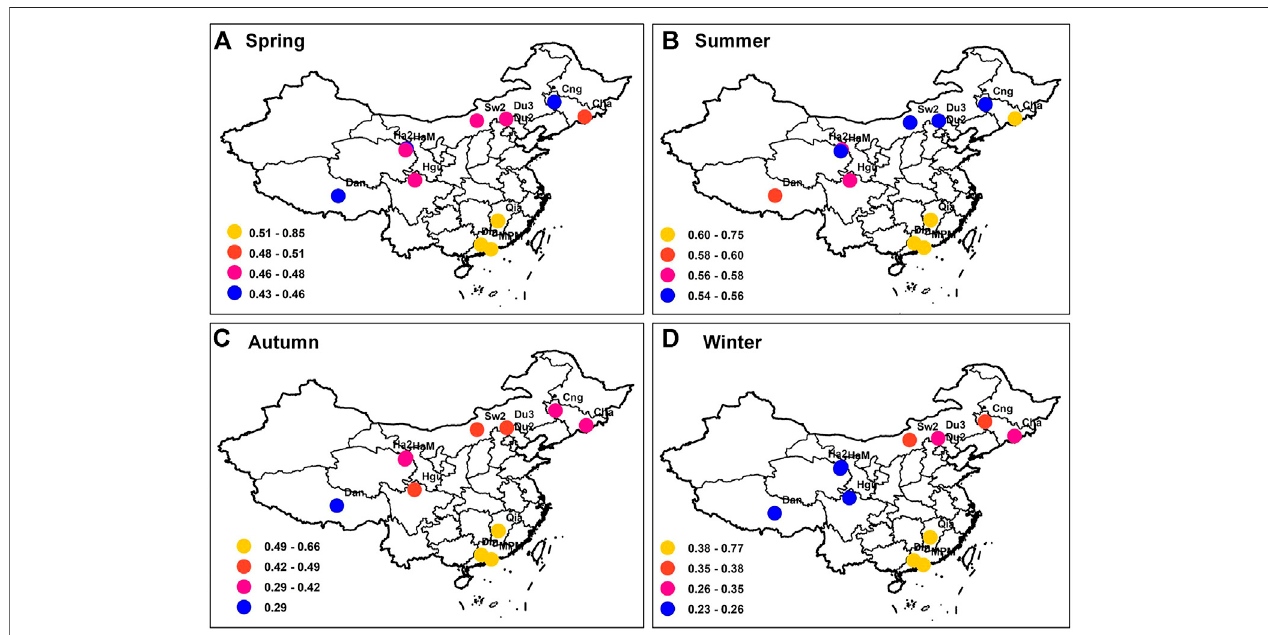
FIGURE6| ThespatialdistributionoftheK d simulatedatallFLUXNETsites. (A – D) arespring(March-April-May),summer(June-July-August),autumn(September- October-November) and winter (Dec-Jan-Feb), respectively.